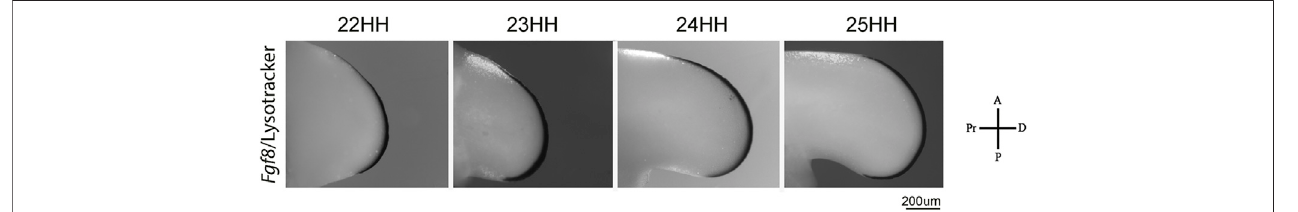
FIGURE 1 | Progressive loss of the apical ectodermal coincides with the apparition of cell death in the anterior margin of the limb. In situ hybridization of Fgf8 gene expression and cell death pattern evidenced by lysotracker stain at limb development stages from 22 to 25 HH. Notice that cell death occurs in regions in which Fgf8 expression is